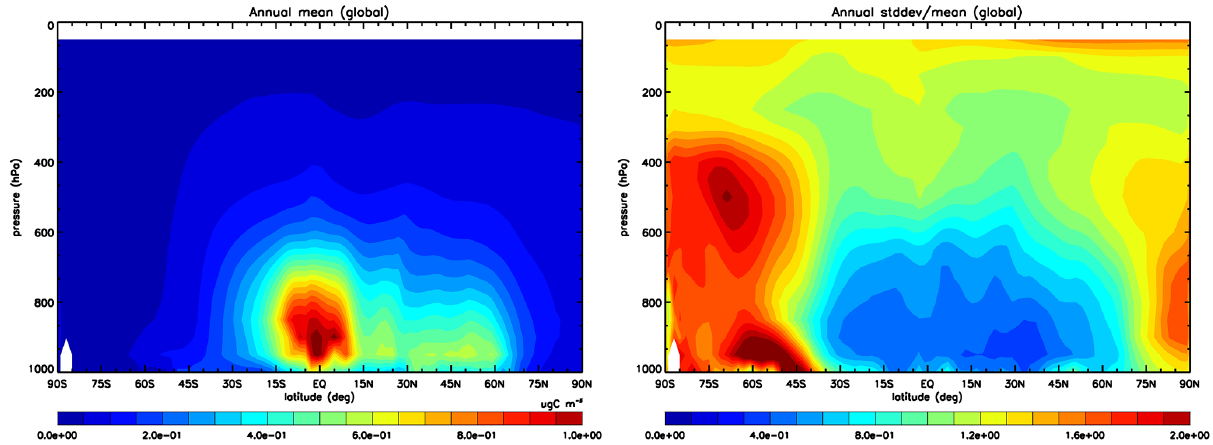
Figure 9. Annual zonal mean of the median model results for OC interpolated at 50hPa steps (left) and model diversity (standard deviation over mean;